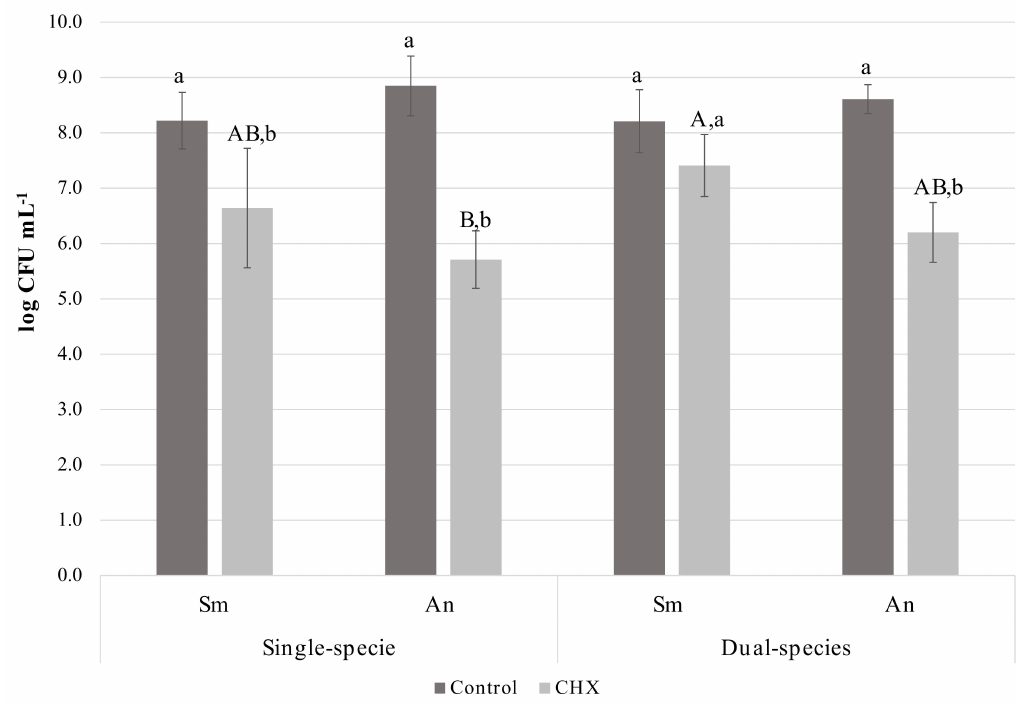
Figure 3. Stress response of single- and dual-species biofilms using DFR. Viability (mean ± sd; Log CFU / mL) in single- and dual-species biofilms of S. mutans and A. naeslundii . An single: A. naeslundii in single-species biofilms; An dual: A. naeslundii in dual-species biofilms; Sm single: S. mutans in single-species biofilms; Sm dual: S. mutans in dual-species biofilms. CHX: chlorhexidine diacetate. Means followed by di ff erent uppercase letters indicate statistically significant di ff erences within chlorhexidine treatment (column). Means followed by di ff erent lowercase letters indicate statistically significant di ff erence within each growth condition (rows) (two-way ANOVA and Tukey test, p <